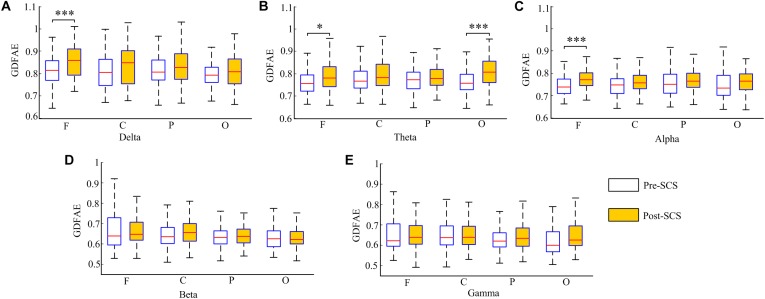
Box plot of the GDFAE for all 16 patients. Each graphic includes both states of all four regions at one frequency band. The symbol “∗∗∗” denotes a p-value less than 0.001, “∗∗” denotes a p-value less than 0.01, and “∗” denotes a p-value less than 0.05.